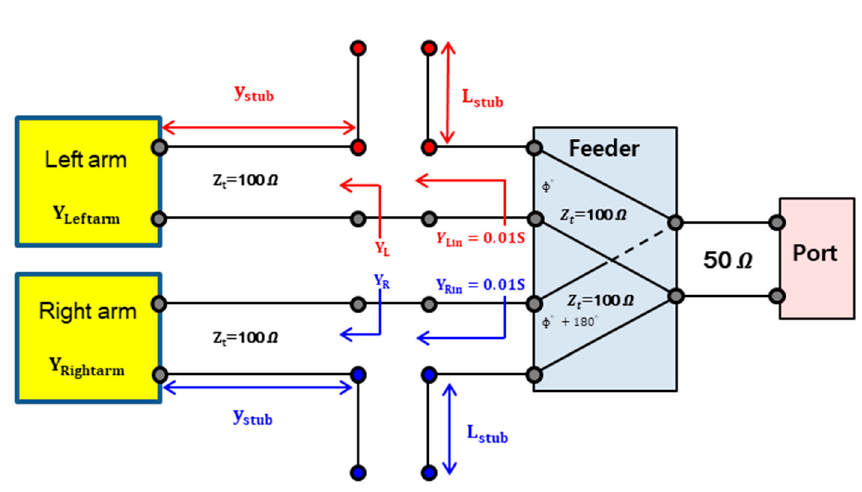
Figure 3. Antenna feed network with tuning stubs for a single inverted-V dipole.